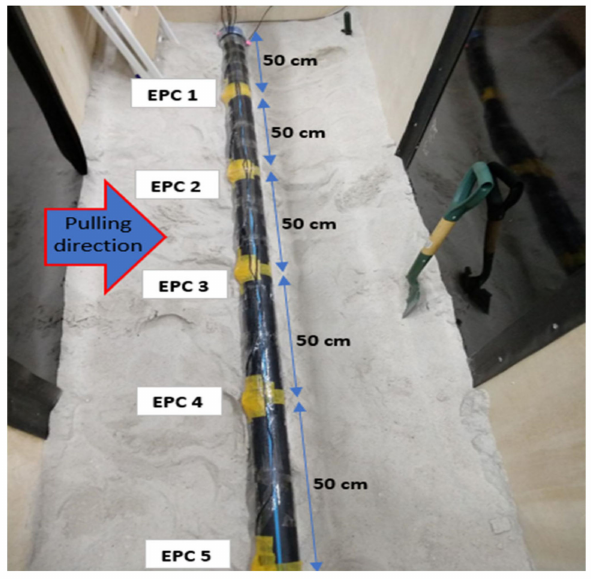
Figure 4. Placement of an HDPE pipe in the middle of the chamber used to assess lateral pipeline–soil interaction in sandy